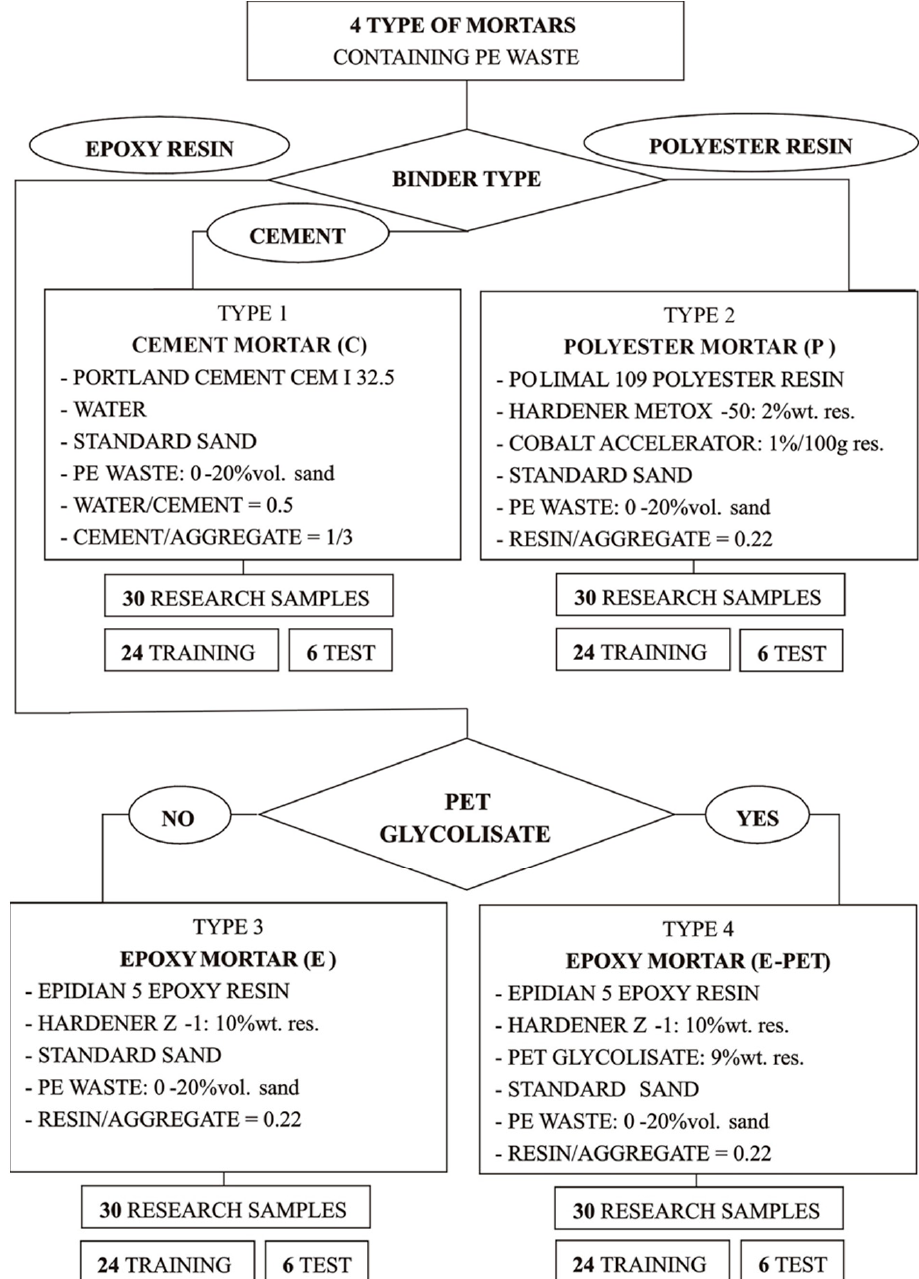
Figure 1. The method of obtaining and division of mortars. For each type of mortar, 30 samples with dimensions of 40 mm × 40 mm × 160 mm were prepared, which were then used to determine the strength parameters (flexural and compressive strength), bulk density and water absorption. From 30 experimental data (separately for a given type of mortar), 6 test data are randomly selected. The remaining results constitute the training data